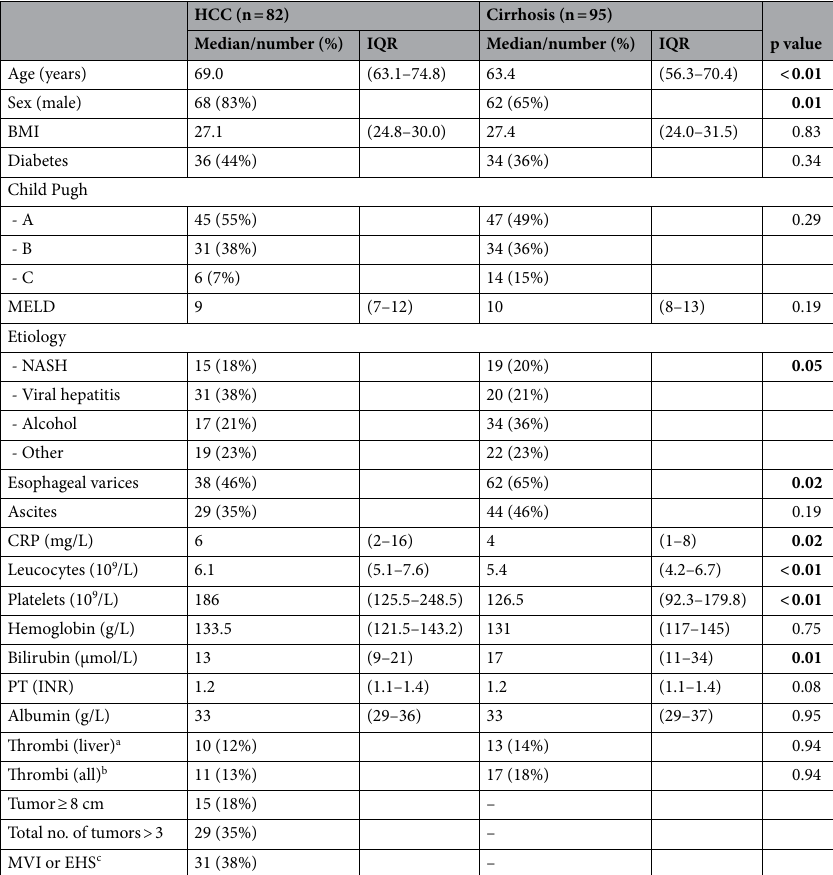
Table 1. Baseline data of patients with HCC or cirrhosis (without HCC). a History of thrombi in liver vessels. b History of thrombi, any vessel. c Macrovascular invasion or extrahepatic spread at time of inclusion. Extrahepatic spread includes lymph node invasion and distant